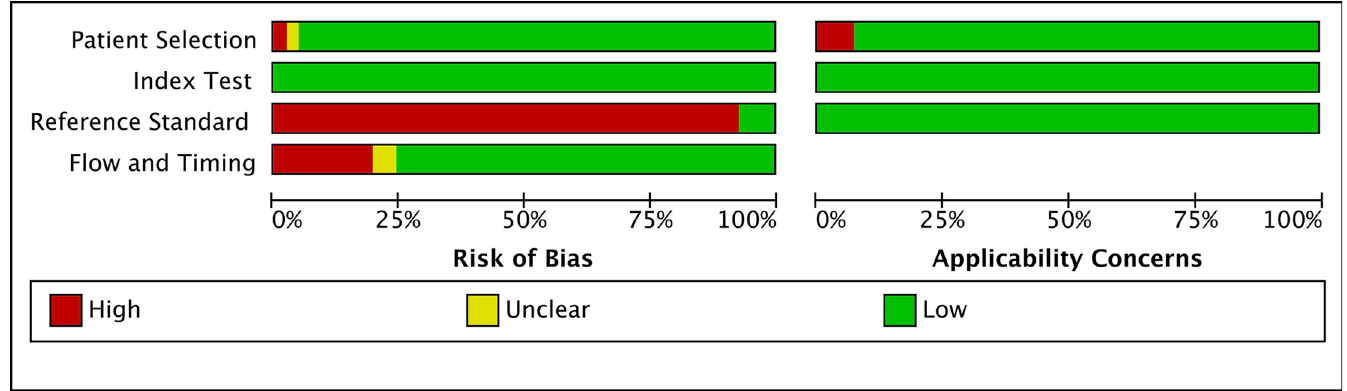
Fig 2. Summary of bias assessment using the QUADAS-2 tool of the studies included in the meta-analysis. QUADAS 2, Quality Assessment of Diagnostic Accuracy Studies.